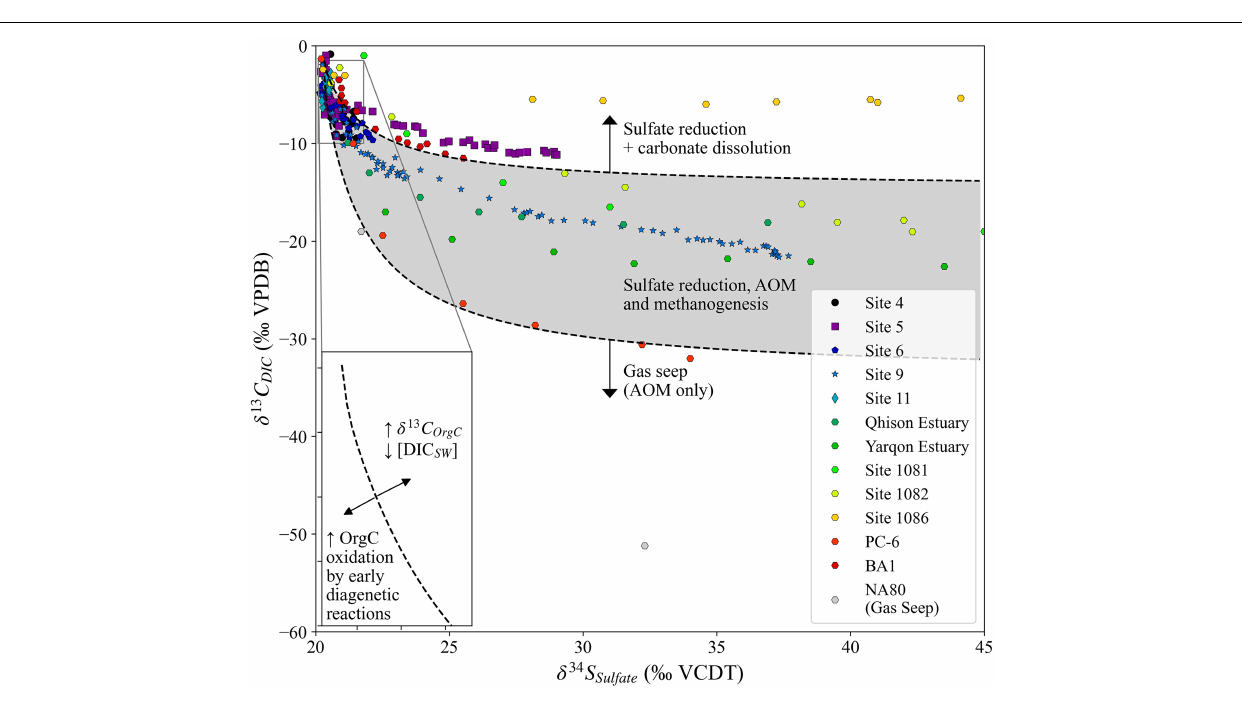
Frontiers in Earth Science |